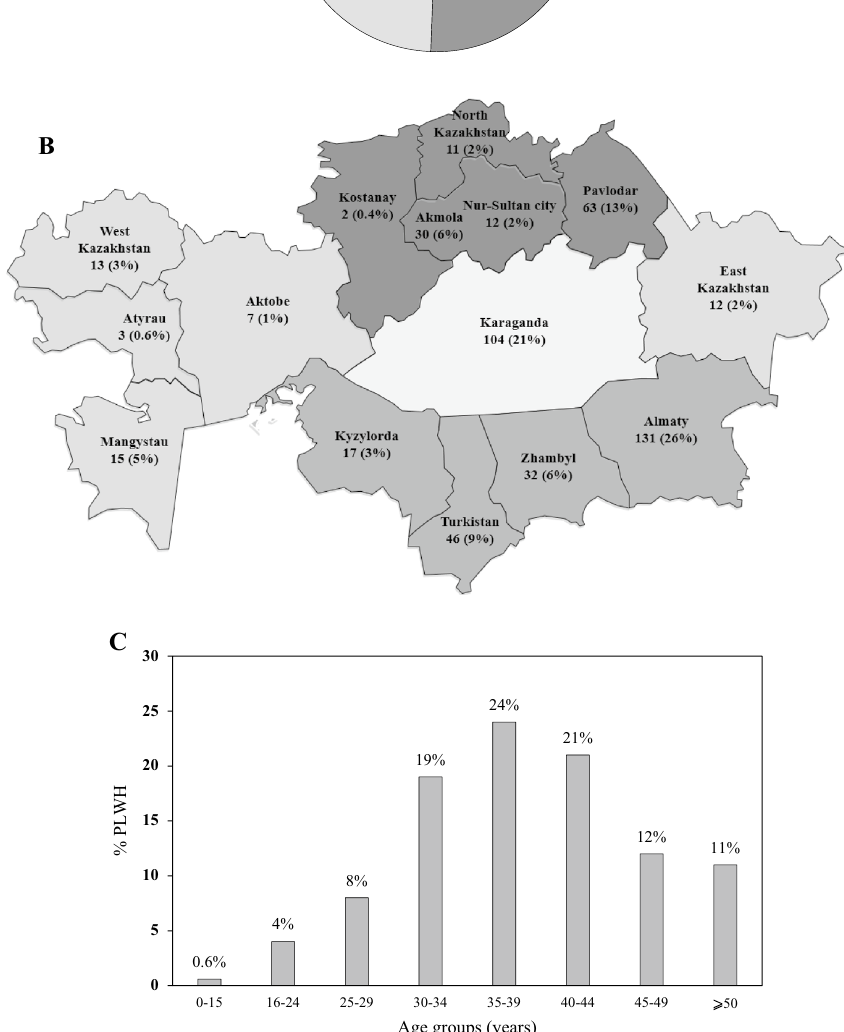
Figure 1. Demographic information of study group with respect to: ( A ) Gender, ( B ) Region of residence, ( C ) Age, ( D ) Year of HIV diagnosis, ( E ) Risk factors, ( F ) Travel history. ( A ) Distribution of males and females among study participants. ( B ) Distribution of HIV positive cases among regions of Kazakhstan, shown as n (percentage). ( C ) Representation of various age groups among the study participants. ( D ) Year of HIV diagnosis among the study participants. ( E ) Reported high-risk groups among the study participants. ( F ) Travel history of study